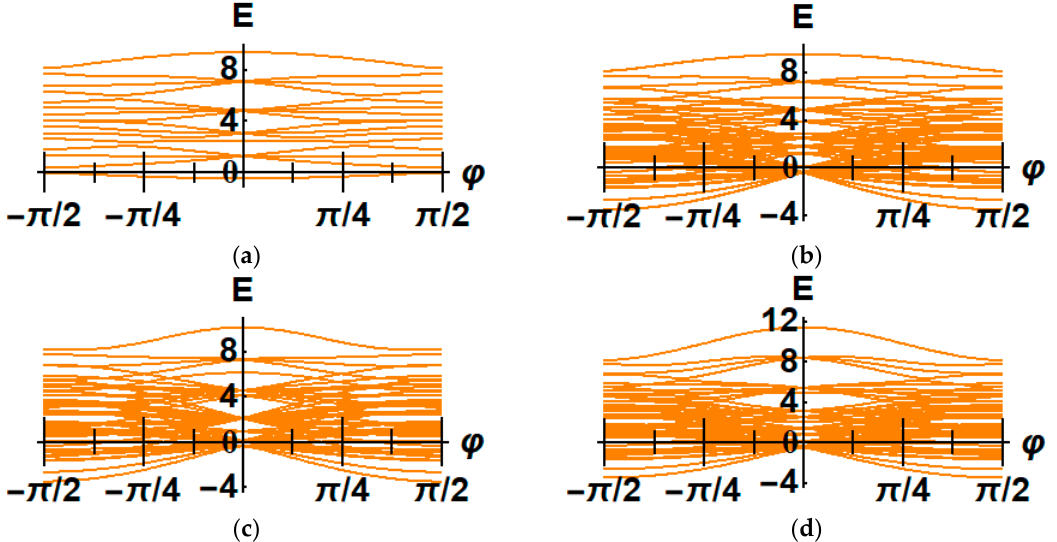
Figure 6. Energy spectrum of four spins in a chain and a second spin interacting with the quantized electromagnetic field. The number of excitations is equal to four. ( a ) Spin chain consist of spins ½; ( b ) Spin chain consists of spin 1, G 1 = cos ( ϕ ) and G 2 = 0; ( c ) Spin chain consists of spin 1, G 1 = 0 and G 2 = cos 2 ( ϕ ) ; ( d ) Spin chain consists of spin 1, G 1 = cos ( ϕ ) and G 2 = cos 2 ( ϕ )